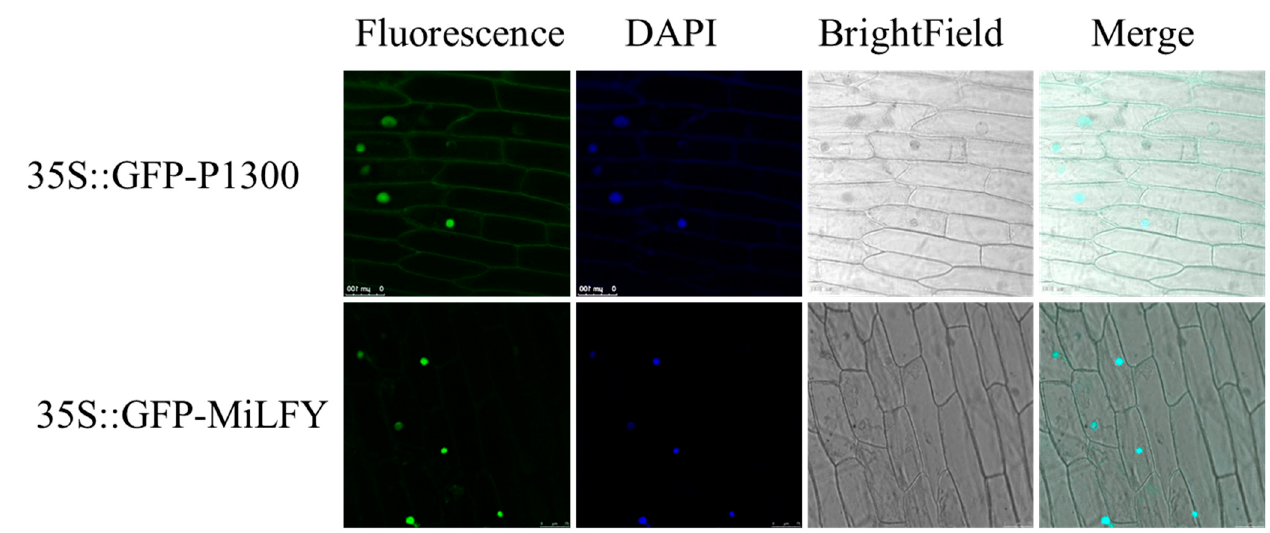
Figure 3. Subcellular localization analysis of the MiLFY protein. The subcellular localization of 35S::GFP-MiLFY and 35S::GFP-P1300 in onion epidermal cells was evaluated.